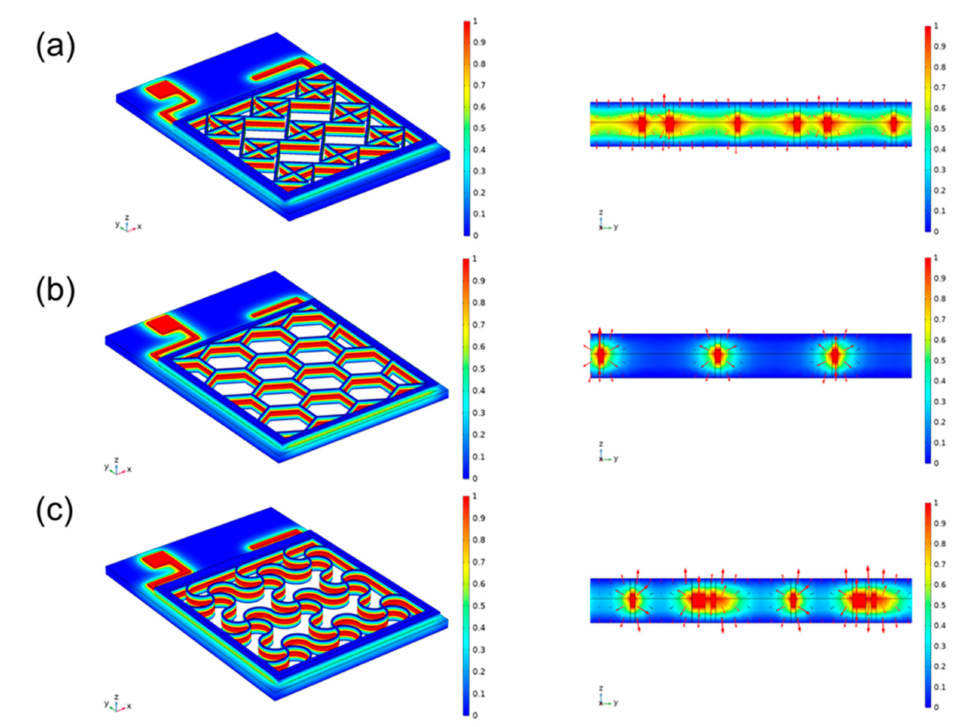
Figure 4. Experimental Section MEMS electrode design left ( a ) cross electrode ( b ) hexagonal electrode. ( c ) serpentine electrode Right Side view of electric field distribution of the combined PET-electrode- hydrogel-skin